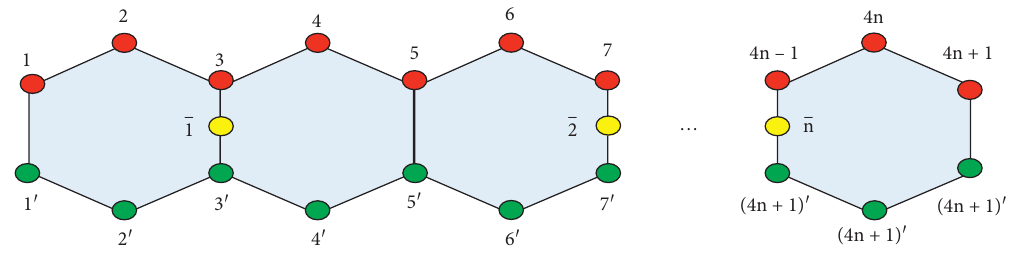
Figure 1: Linear heptagonal networks H